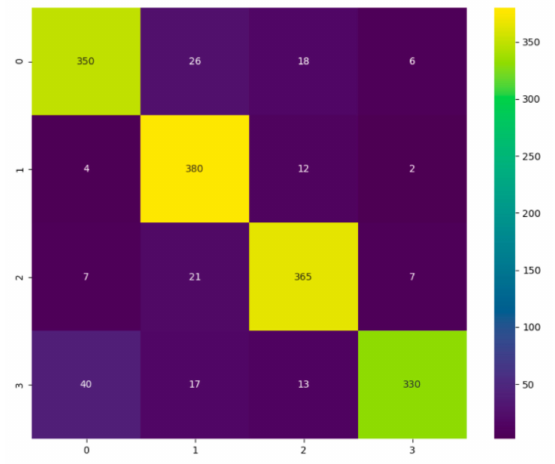
Figure 11. Exemplary confusion matrix for a set of 400 validation PD images subdivided into four classes (start, middle, end and noise) representing the insulation stages of electrical insulating aging monitoring. Each column of the confusion matrix refers to instances of the predicted class, while each row exhibits instances of the actual